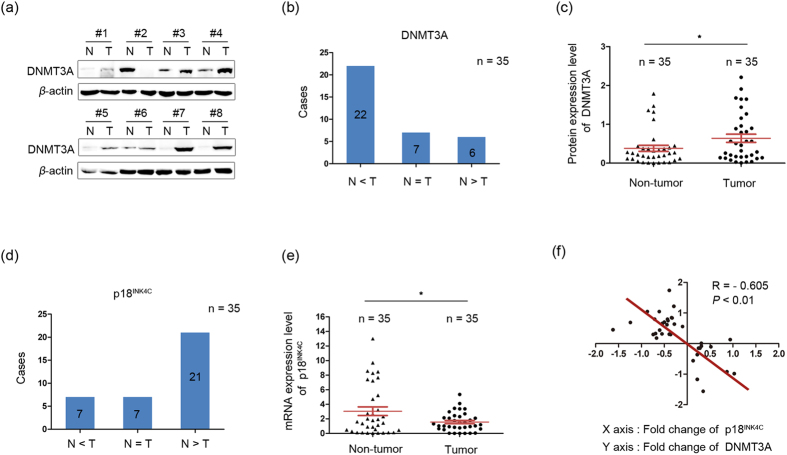
Elevated DNMT3A expression is correlated with p18INK4C downregulation in clinical GC specimens.(a) Western blot analysis of DNMT3A in 8 representative GC tissues (T) and paired adjacent non-tumor (N) tissues. β-actin was used as a loading control. (b) The relative protein expression levels of DNMT3A in 35 paired GC and adjacent non-tumor tissues divided into three groups (N > T, N = T and N < T) based on relative expression scores of greater than or less than 2-fold. The number of cases is shown for every group. (c) Scatter plots of relative DNMT3A protein expression in 35 GC and paired adjacent non-tumor tissues. In both panels, the red lines indicate the mean ± SEM (*P < 0.05). All protein samples were derived from the same experiment, and SDS-PAGE gels were processed in parallel. (d) The relative mRNA expression levels of p18INK4C in 35 paired GC and adjacent non-tumor tissues divided into three groups (N > T, N = T and N < T) based on relative expression scores of greater than or less than 2-fold. The number of cases is shown for each group. (e) Scatter plots of relative p18INK4C mRNA expression in 35 GC and adjacent non-tumor tissues. In both panels, the red lines indicate the mean ± SEM (*P < 0.05). (f) Correlation between DNMT3A protein and p18INK4C mRNA expression in 35 clinical samples, with linear regression lines and correlation significance (R = −0.605; **P < 0.01).